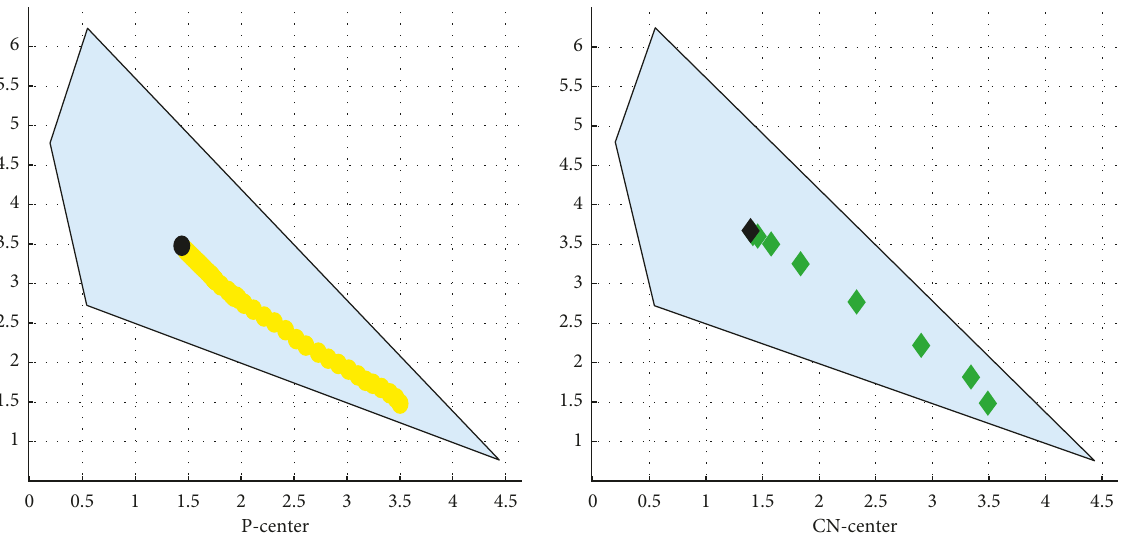
Figure 1: Polytope 1, P-center is obtained in 56 iterations but CN-center is obtained in just 11 iterations. Centrality wise both looked equivalent.